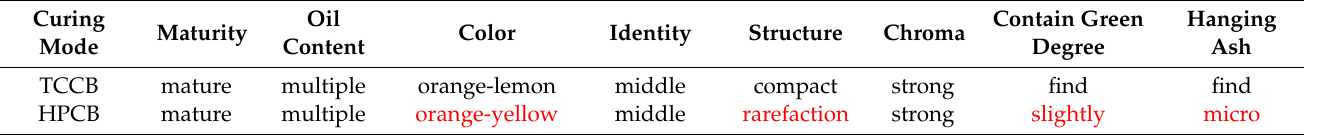
Table 7. Quality evaluation of the tobacco appearance after